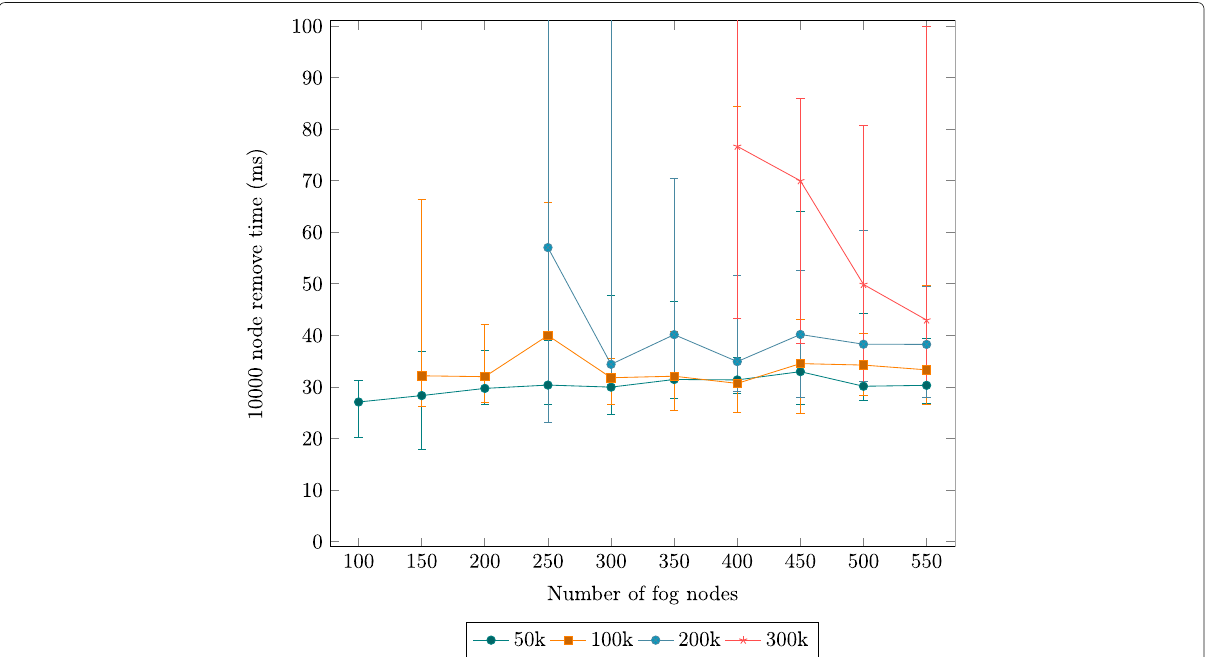
Fig. 6 Time required to move 10000 edge nodes to another fog node in service topologies of varying sizes. Legend numbers represent thousands of edge nodes